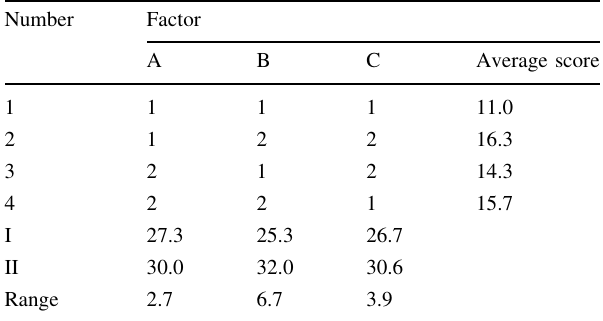
Table 5 Confined blasting test